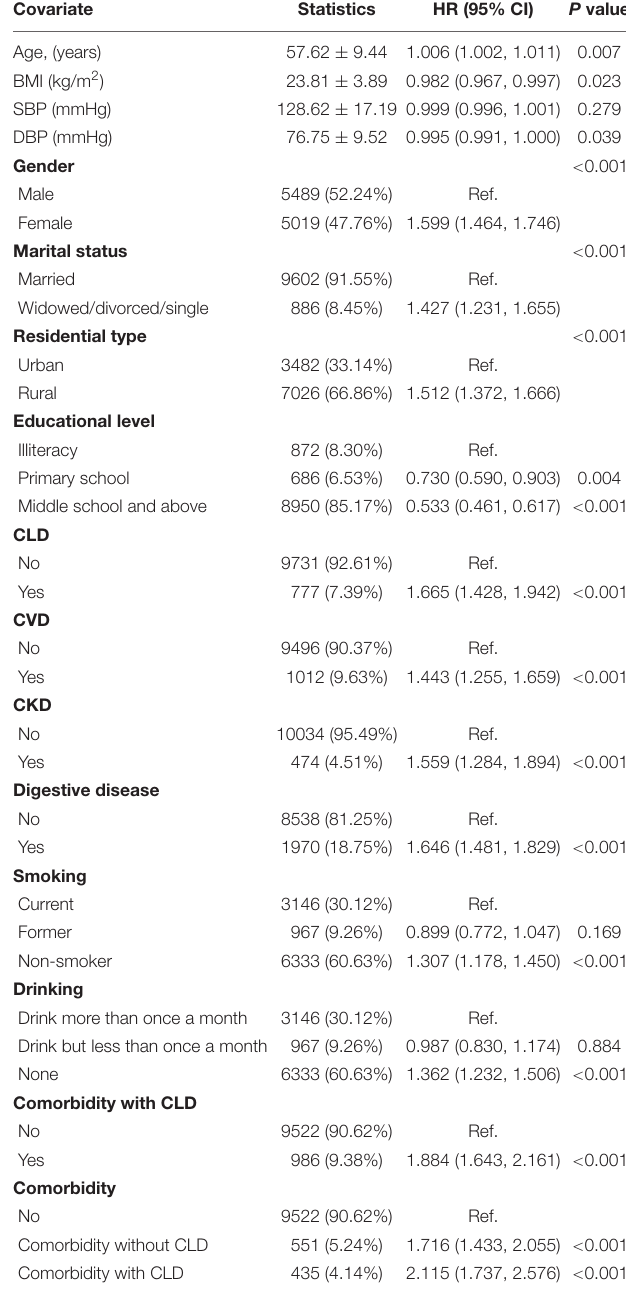
TABLE 3 | Univariate analysis for